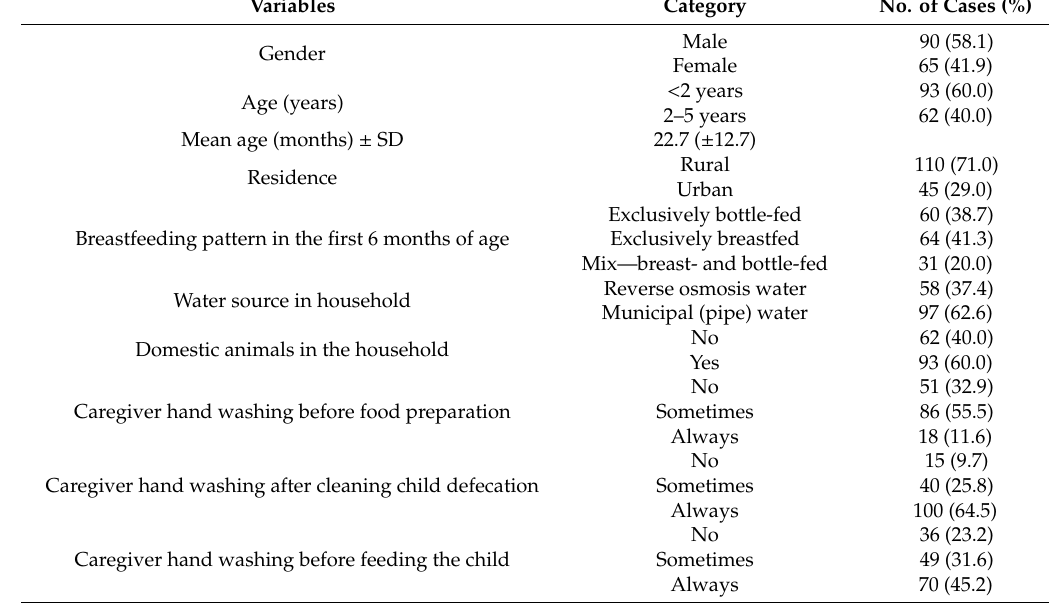
Table 2. Descriptive characteristics of diarrheal cases ( n = 155) among children < 5 years.